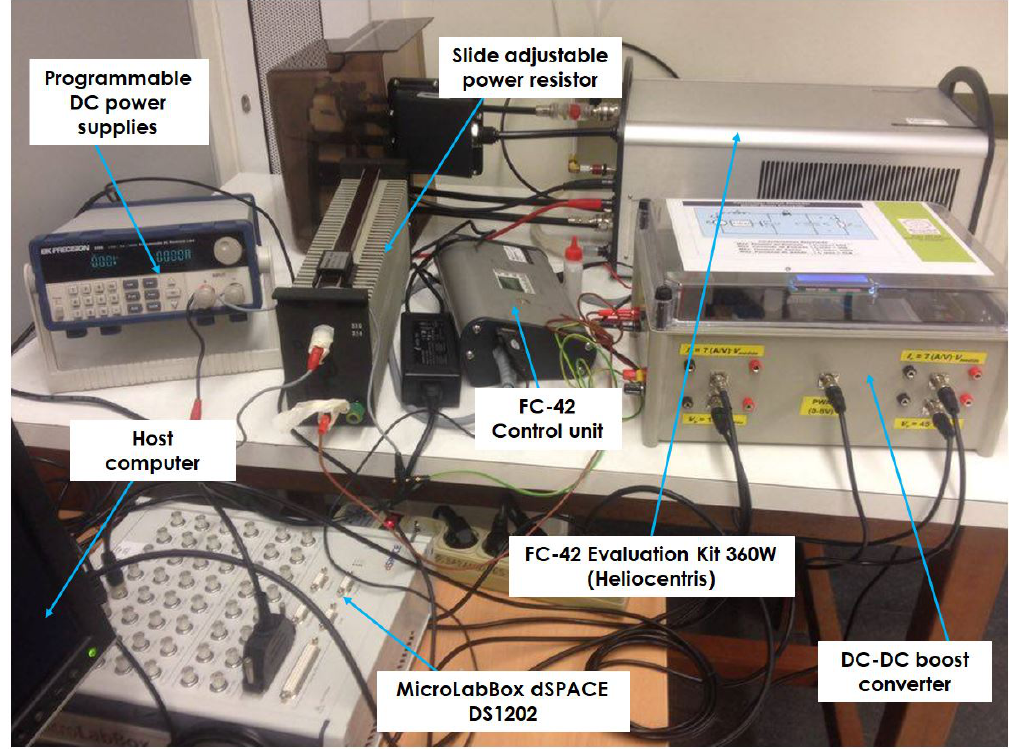
Figure 11. Experimental setup.